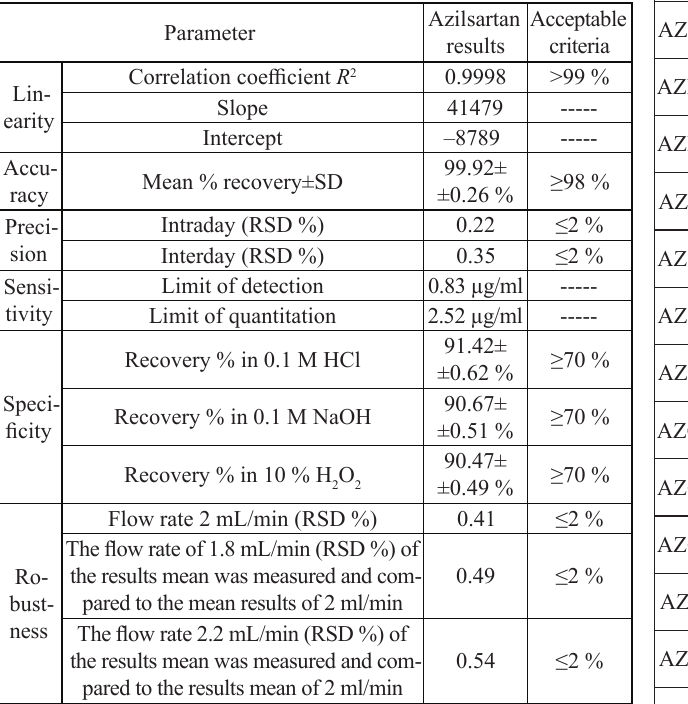
Fig. 3. Calibration curve of azilsartan medoxomil Validation parameters of analytical